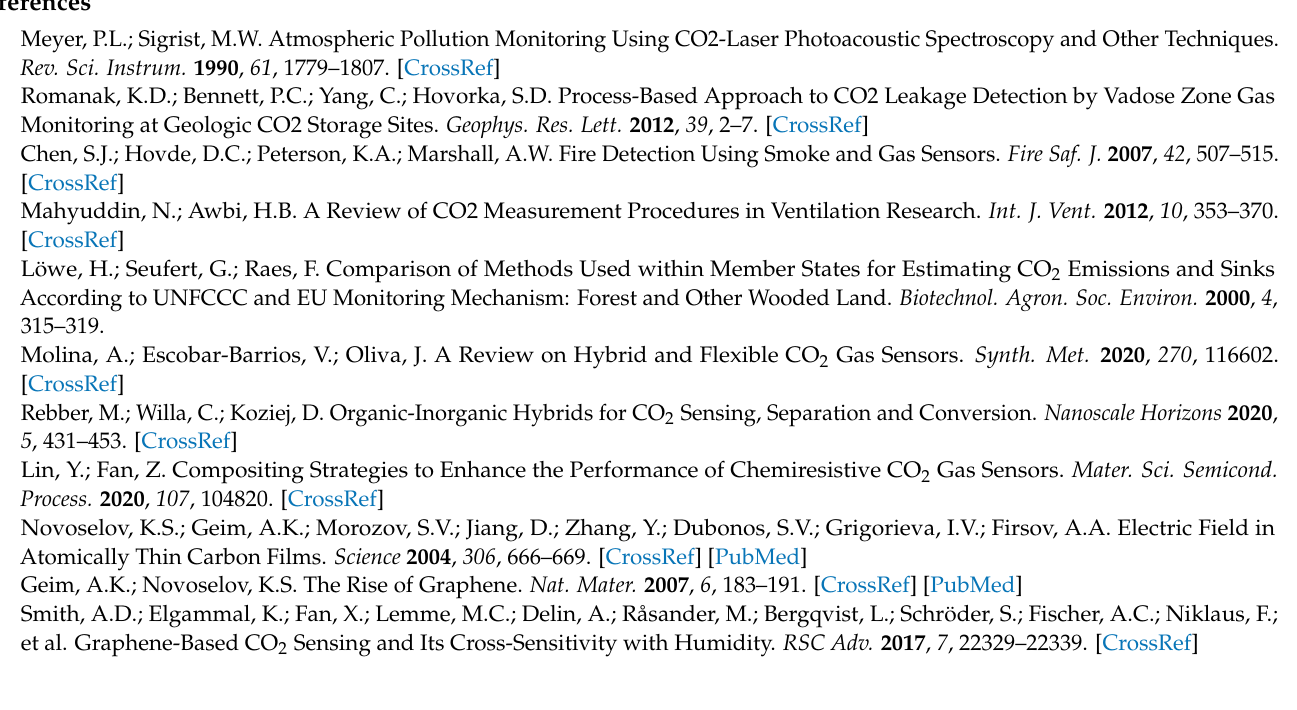
Figure S2: Temperature stability during the measurements; Figure S3: Exponential fit to experimental data; Table S1: Original data for ∆ R S